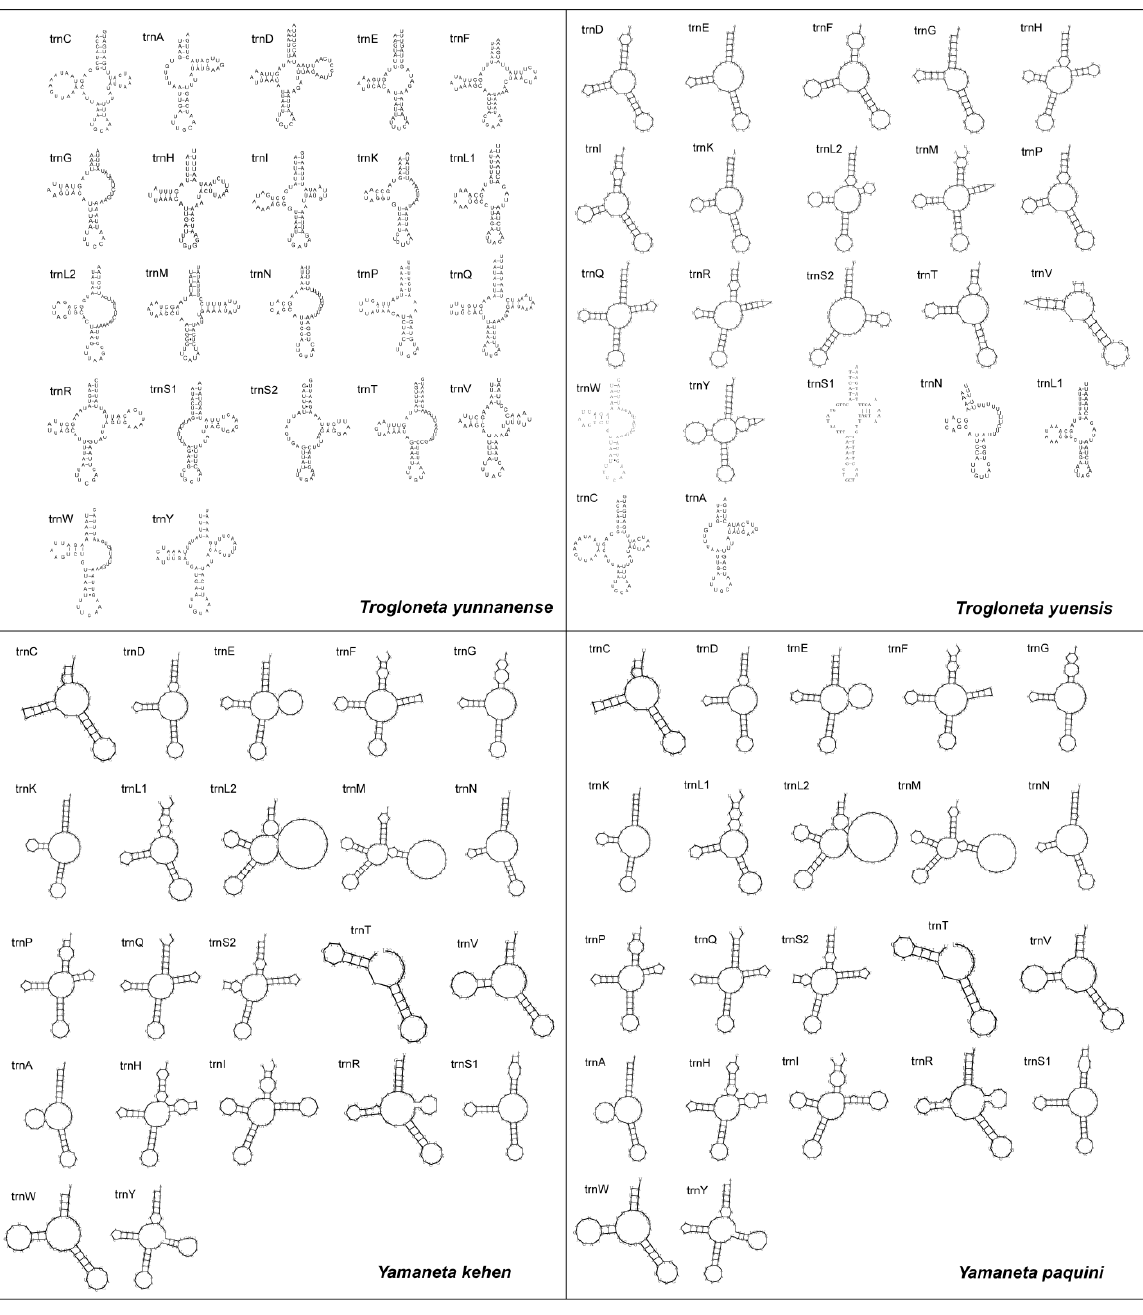
Figure 4. Cloverleaf structure of the 22 inferred tRNAs in the mitogenomes of Trogloneta and Yamaneta mitogenomes.